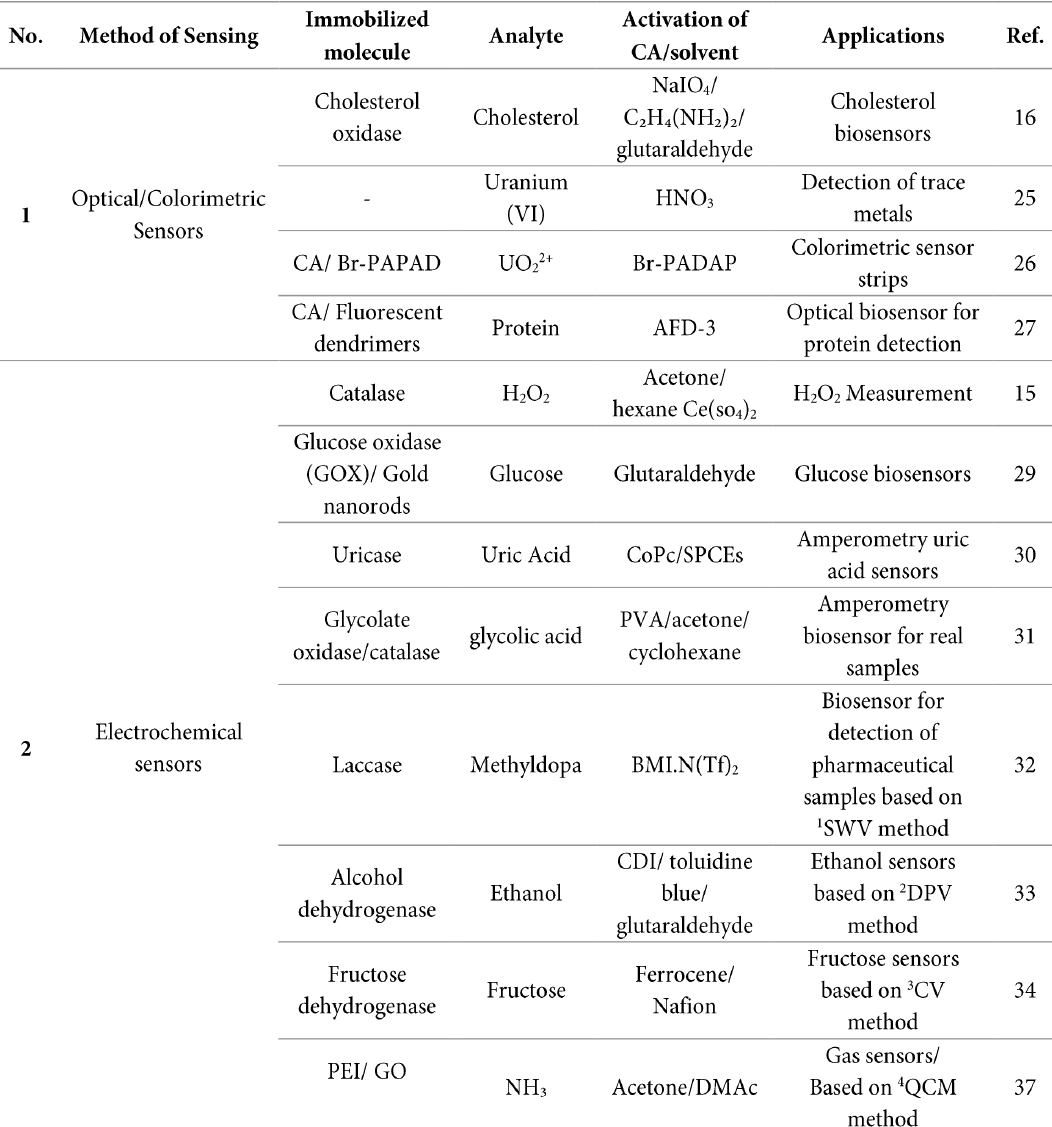
Table 1. Summary of cellulose-based sensors, type of modification/activation, and potential